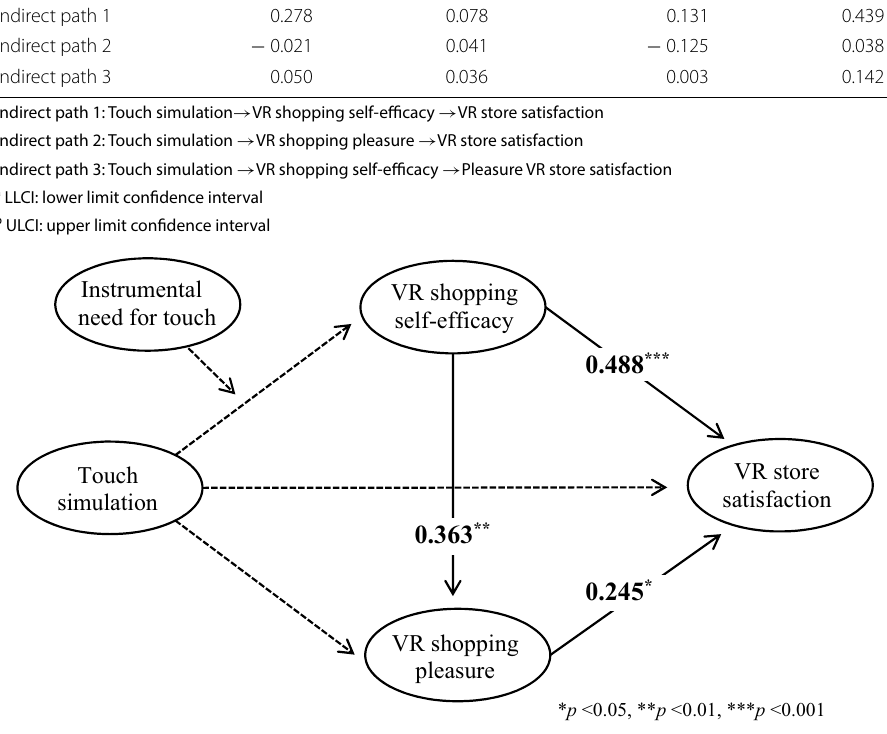
Fig. 3 Moderating model of instrumental need for